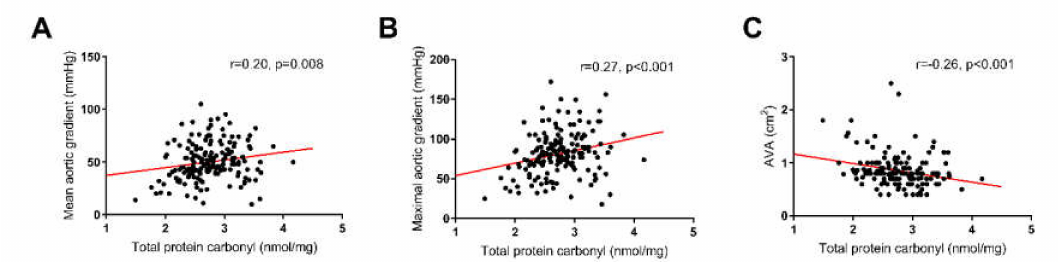
Figure 1. Correlations of the total protein carbonyl levels with the echocardiographic parameters: